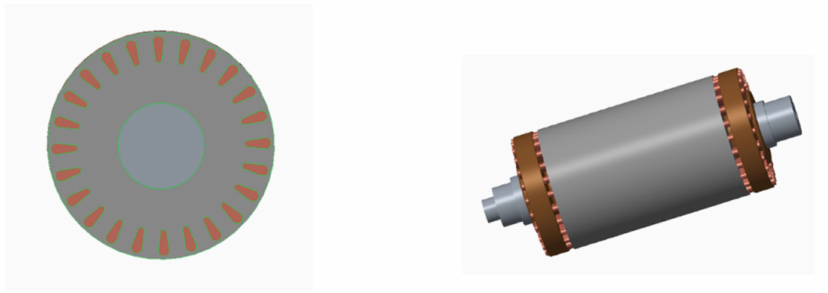
Figure 7. Resultant induction machine rotor geometry.